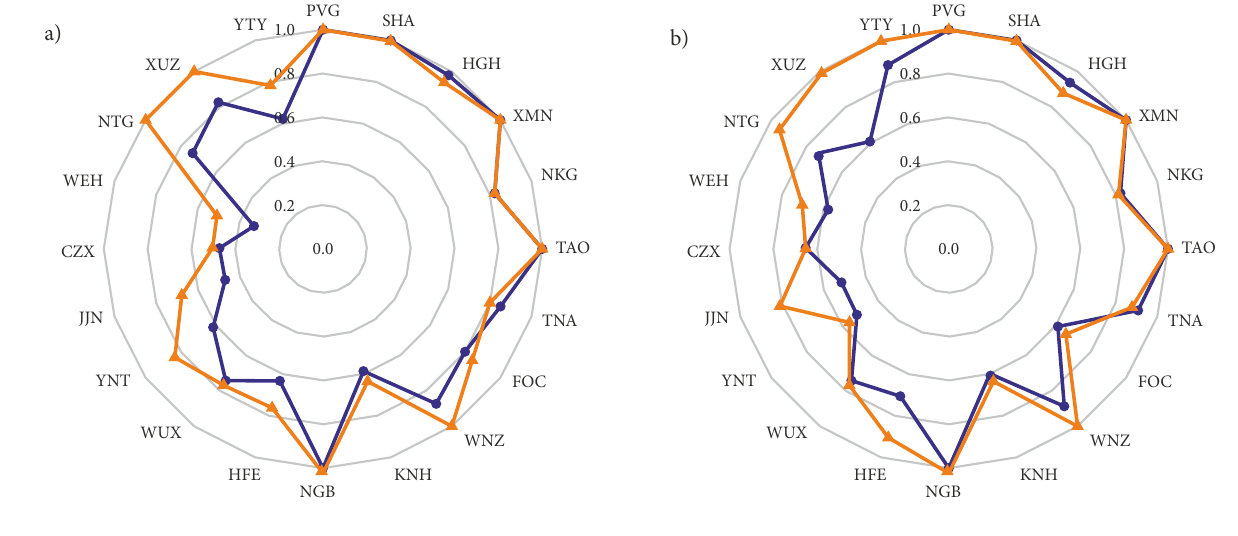
Figure 5. Average TE of two periods: a – from 2013 to 2015; b – from 2016 to